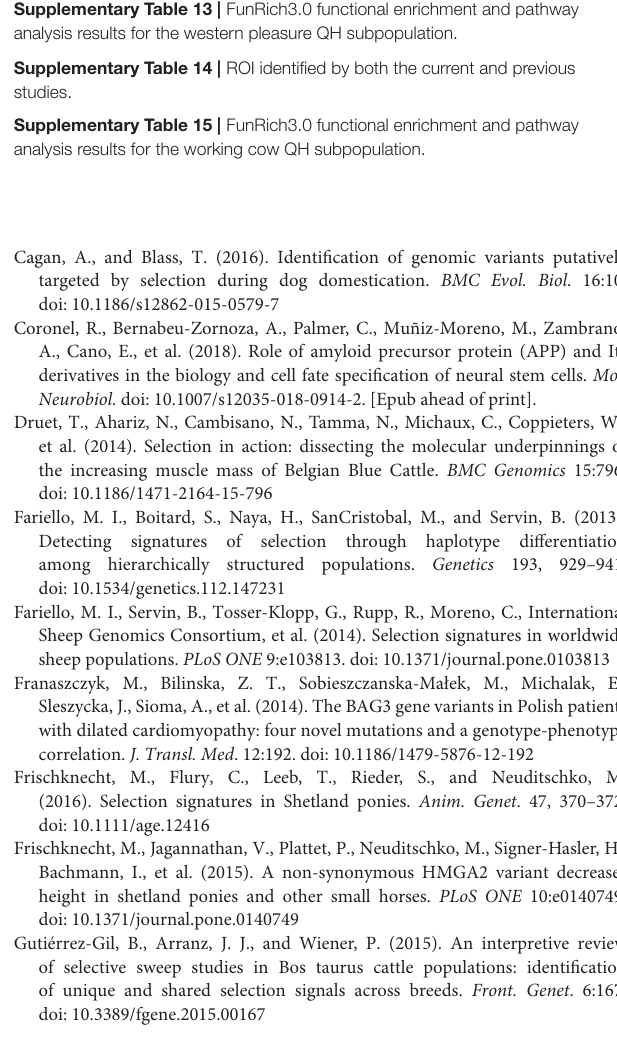
Supplementary Table 13 | FunRich3.0 functional enrichment and pathway analysis results for the western pleasure QH subpopulation. Supplementary Table 14 | ROI identified by both the current and previous